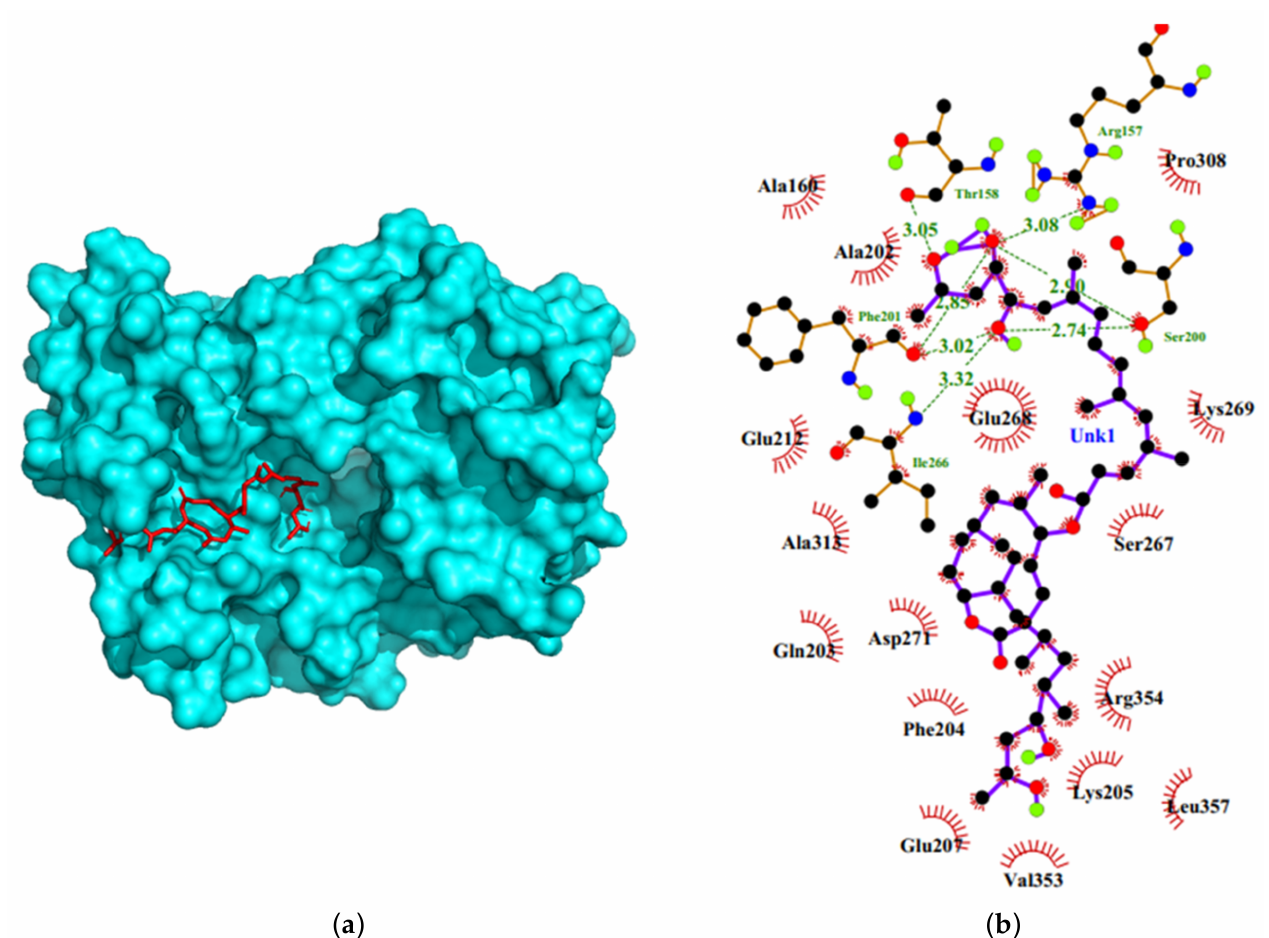
Figure 1. Binding mode and Ligplot+ characterization of the MLN-CTD complex. ( a ) Docking pose of MLN in one of the binding pockets of CTD. ( b ) Two-dimensional representation of the MLN- CTD protein-ligand complex. The ball and stick model of MLN compound structure has covalent bound elements depicted for different elements i.e., Carbon as black, Oxygen red, Nitrogen blue and hydrogen as green when not bound to carbon, carbon bound hydrogen not shown to avoid